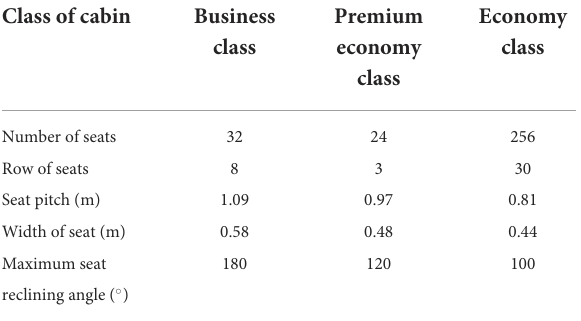
TABLE 2 Basic parameters of cabin interior